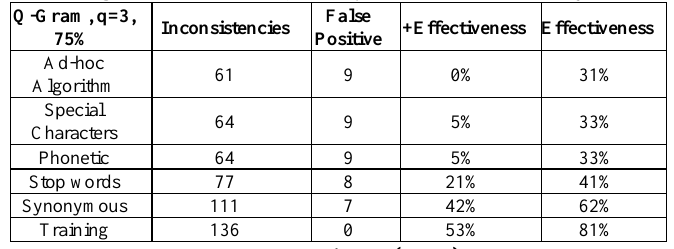
Table 10: Results obtained with data cleaning process using the algorithm Q-Grams, with q=3 and 75%